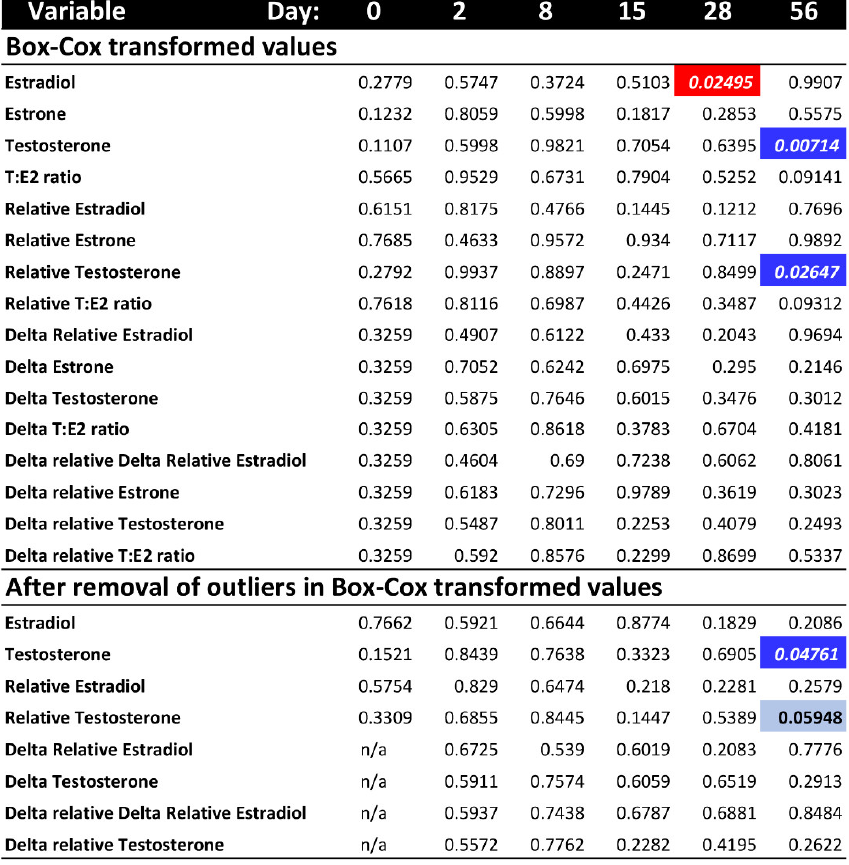
Figure 2. p -values of the post hoc ANOVA tests per sampling day for each hormone variable, after Box-Cox transformation and outlier removal (no outliers were detected after Box-Cox transformation for estrone or T:E2 ratio). Colored cells indicate significant p -values <0.05 (bright colors) or marginally significant (light blue). Red indicates higher hormone level at warmer temperature. Blue indicates higher hormone level at colder temperature.